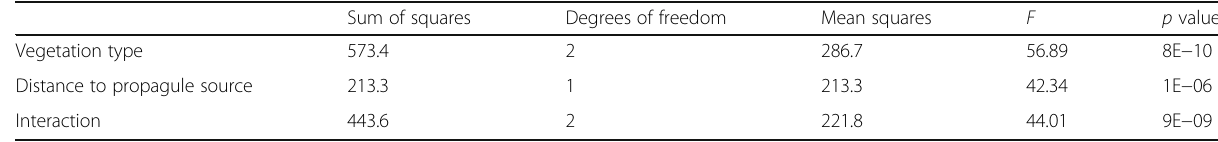
Table 3 Factorial ANOVA for the five largest individuals within each coverage-distance class Sum of squares Degrees of freedom Mean squares F p